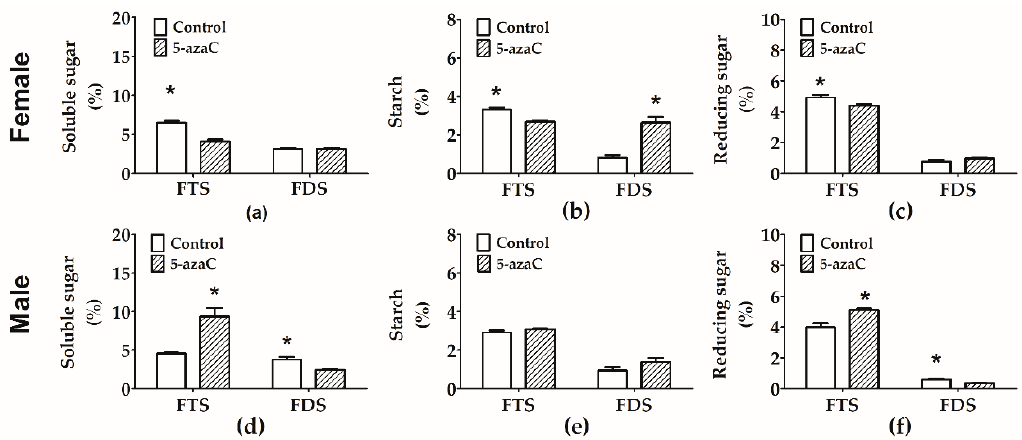
Figure 3. Effects of 5-azaC on the carbohydrate contents of male and female Salix viminalis trees. ( a–f ) Contents of soluble sugars ( a , d ), starch ( b , e ) and reducing sugars ( c , f ) in the female ( a–c ) and male ( d–f ) trees. FTS, flower transition stage; FDS, flower development stage. Least significant difference (LSD) tests were used to determine any significant differences between the treatment and control groups. Data are mean ± SE, n = 3. *, Significant difference between treatment and control ( p < 0.05); **, significant difference between treatment and control ( p < 0.01).